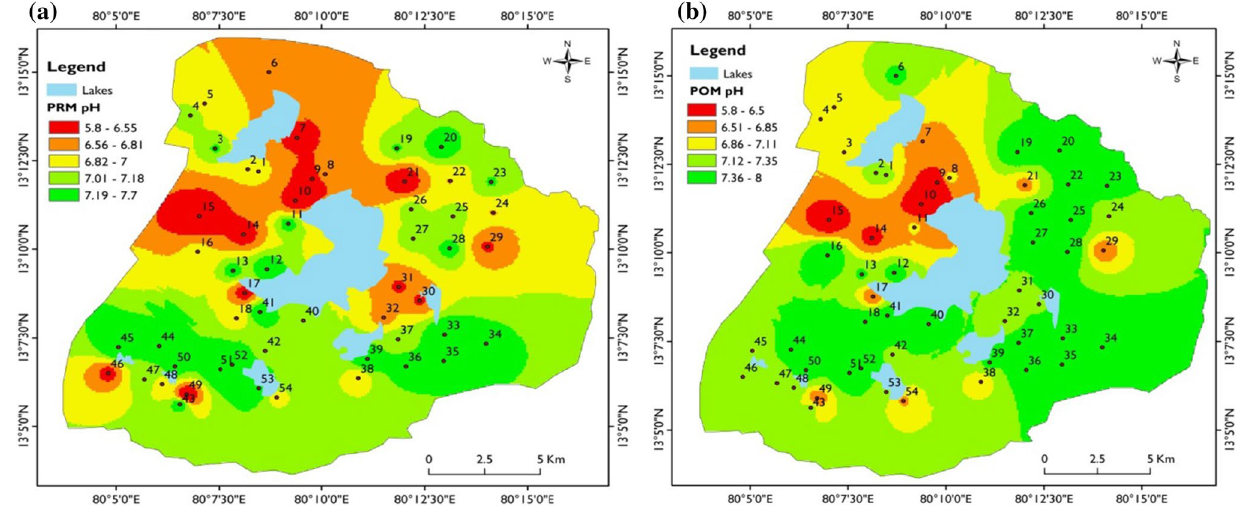
Fig. 2 a , b Spatial variation of pH in the groundwater for pre-monsoon and post-monsoon